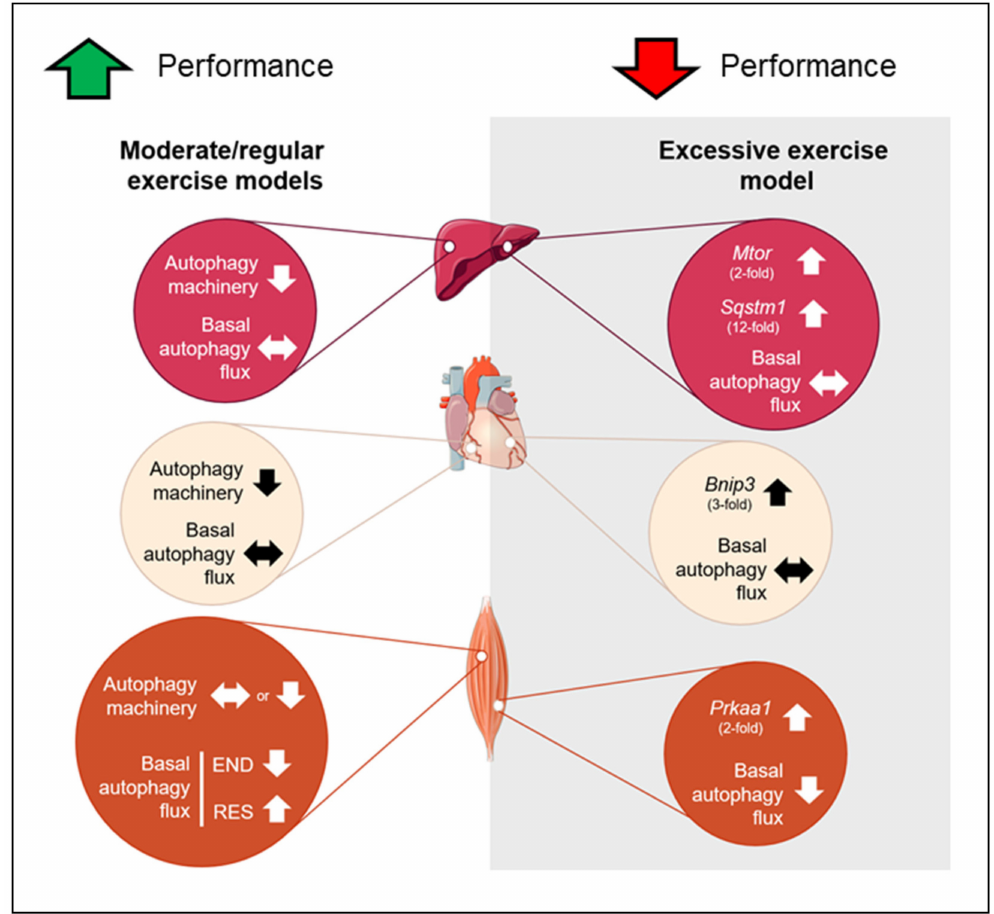
Figure 9. Schematic presentation of the main findings. Red circles represent the adaptations in liver, cream circles represent the adaptations in heart and orange circles represent the adaptations in skeletal muscle for moderate and excessive exercise models. Up arrows indicate upregulation, down arrows indicate downregulation and side arrow indicate no